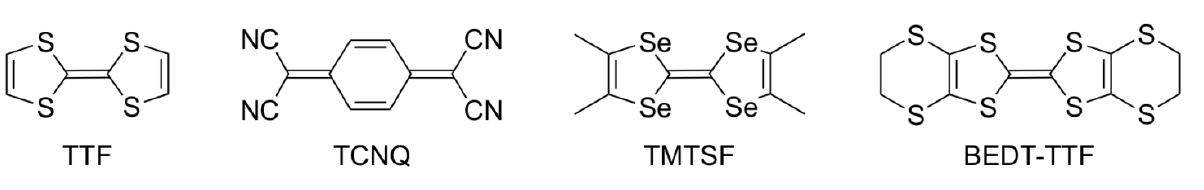
Figure 1. Components of organic molecular